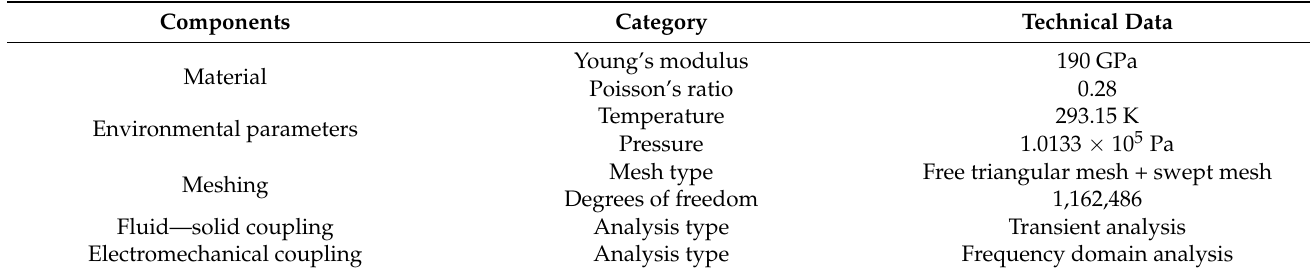
Table 2. Technical data of simulation model.